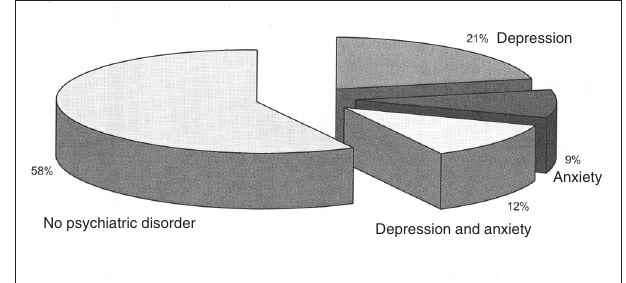
Fig. 2. Erectile dysfunction and co-morbid psychi- atric disorders. Table II. Severity and risk factors for erectile